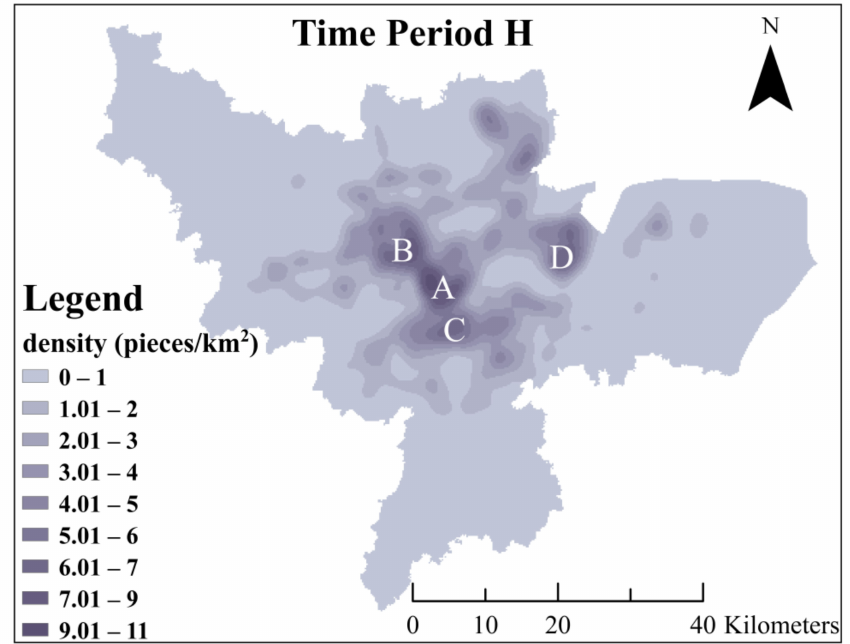
Figure 8. Density of street names in time period H (2010). Four high density regions (A, B, C, D) are the old urban zone near the lake, the urban zone around the canal, Binjiang high-tech zone, and Xiasha university zone